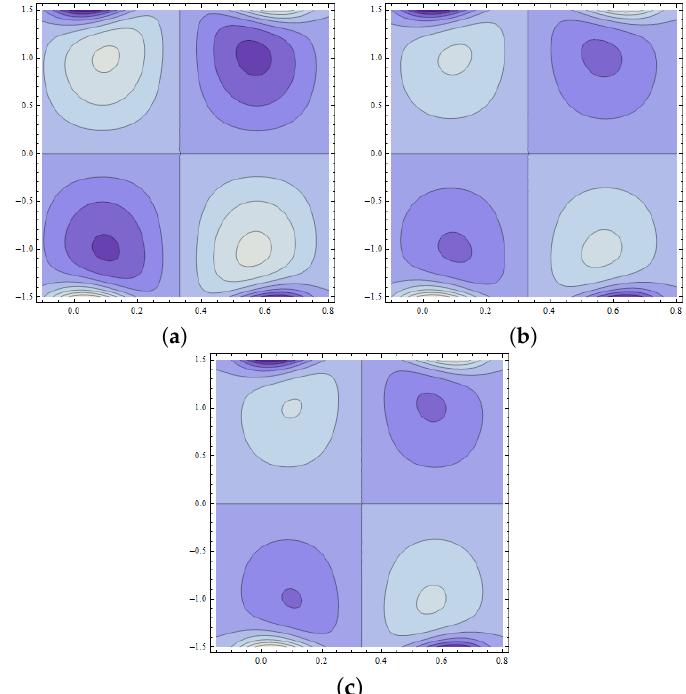
Figure 23. Pattern of streamlines when (cid:101) = 0.1, t = 0.1, m 1 = 2, E 1 = 0.2, E 2 = 0.2, E 3 = 0.3, n = 0.4 and We = 0.4 with ( a ) m = 0, ( b ) m = 1.5, ( c ) m =